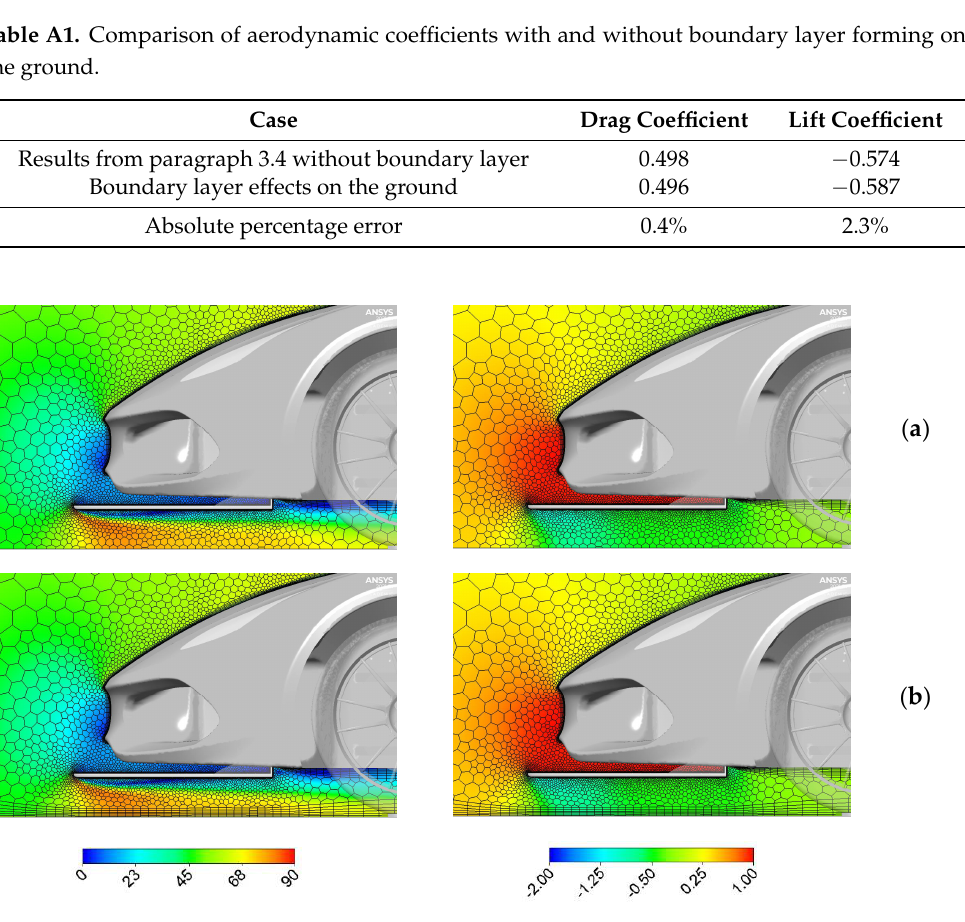
Figure A1. Contours of velocity (m/s) (left column) and pressure coefficient (right column) on the symmetry plane with superimposed mesh edges: ( a ) Results from paragraph 3.4 without boundary layer; ( b ) Results including boundary layer effects on the ground.